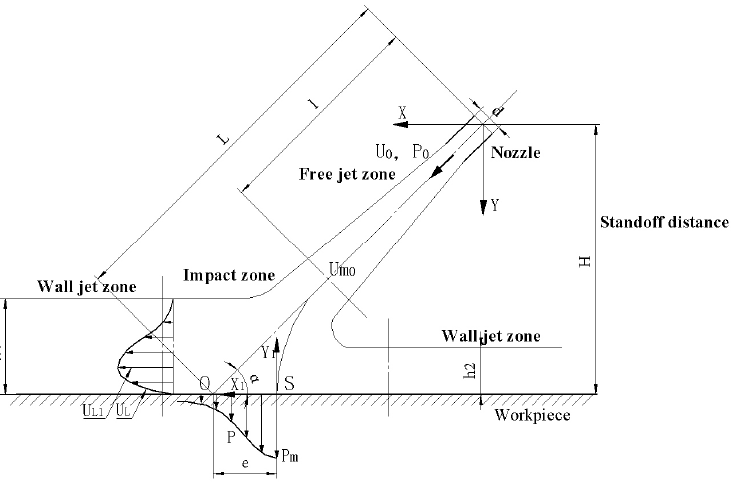
Figure 2. A schematic diagram of the oblique incidence structure of AWJ.